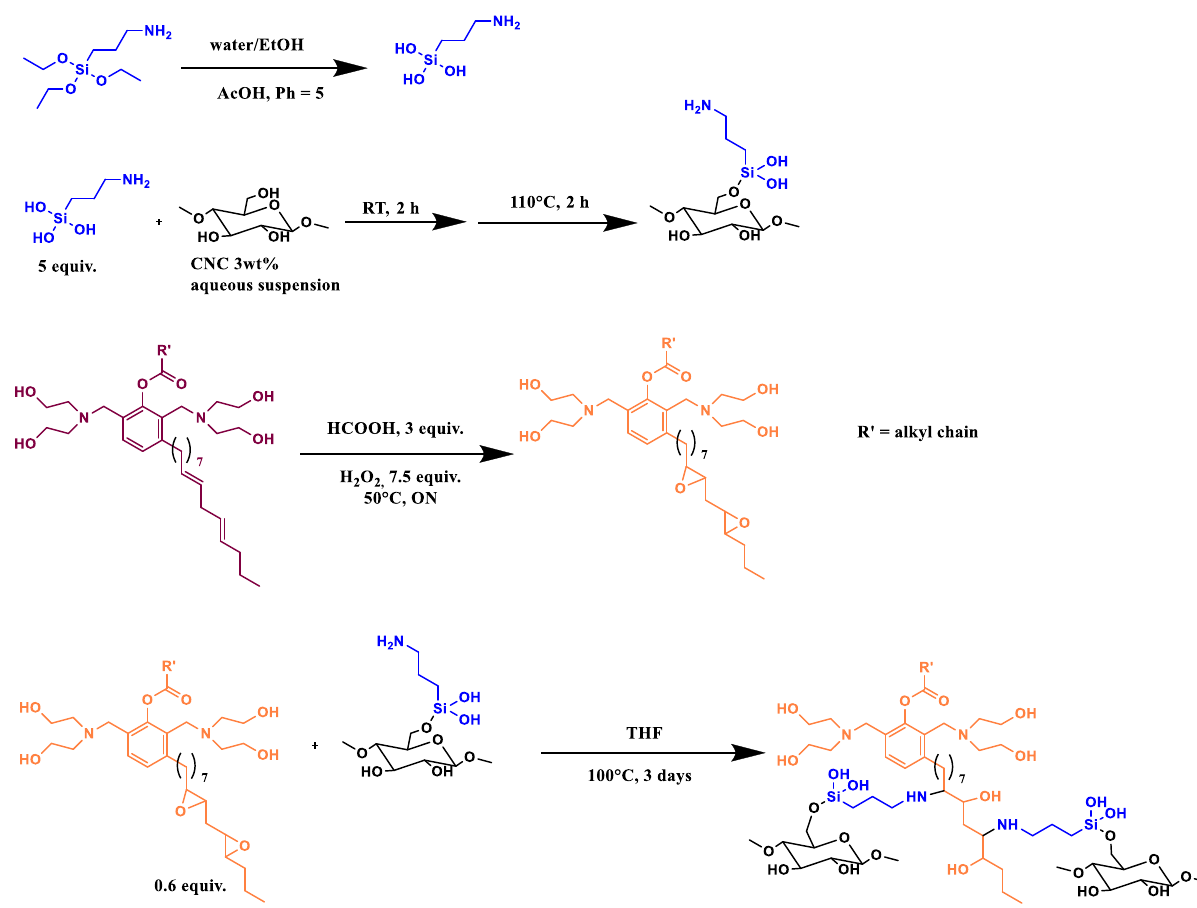
Table 2. Amount of reagents used in the PU foams formulation